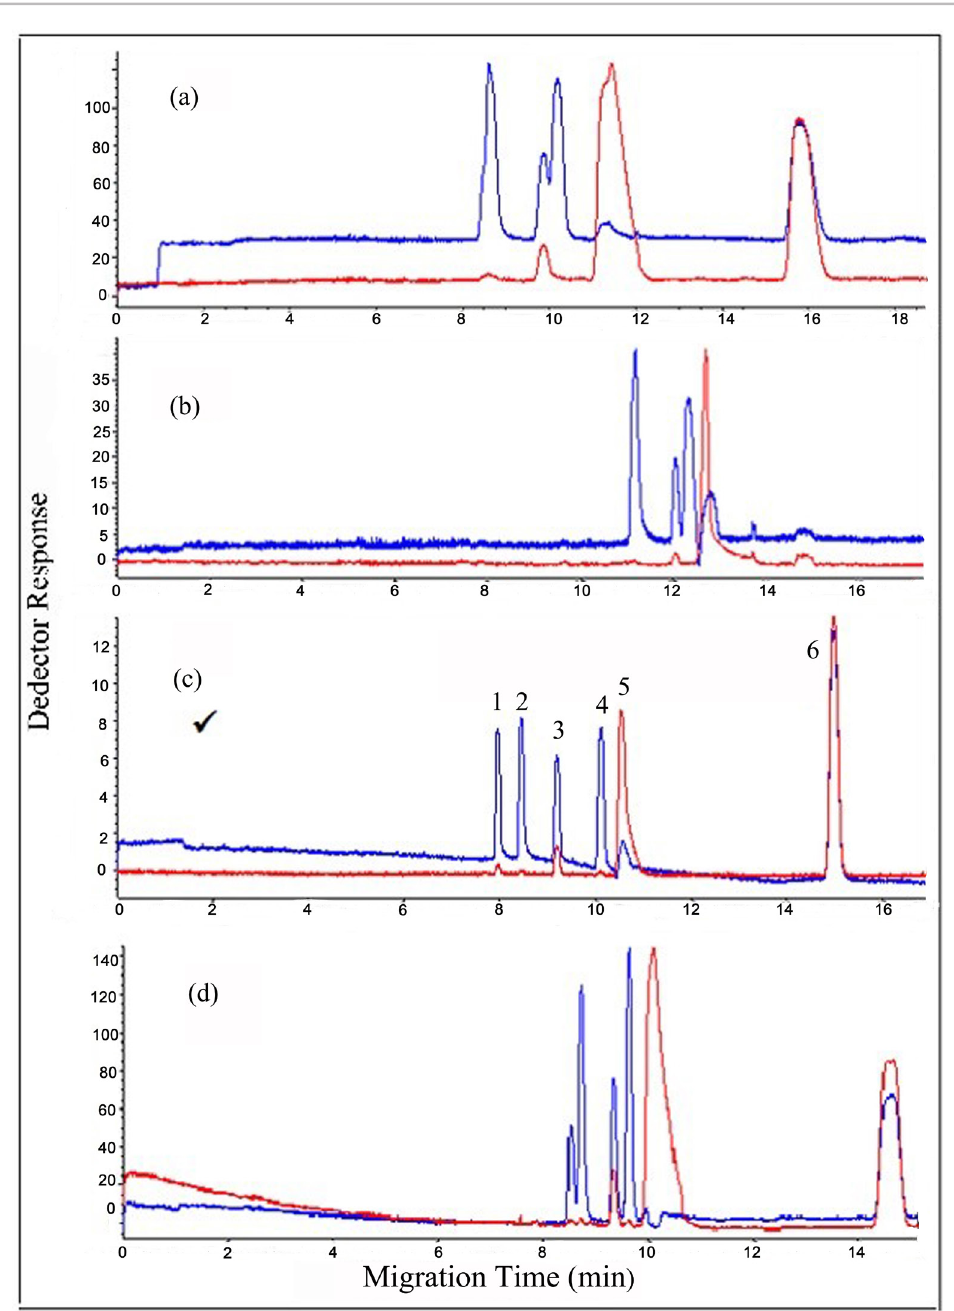
Figure 2 - Effect of buffer concentration on analysis λ=214 nm (blue line), λ=257 nm (red line), Buffer: NaBorat (pH 8), Buffer concentrations: a)25 mM b)50 mM c)75 mM d)100 mM, Conditions: Capillary diameter 50 μm, Hydrodynamic injection Pinj=50 mbar, Isolation Voltage=30 kV, T: 20ºC, Peaks: 1)DEX 2)EPH 3)CHL 4)PSE 5)4-AP